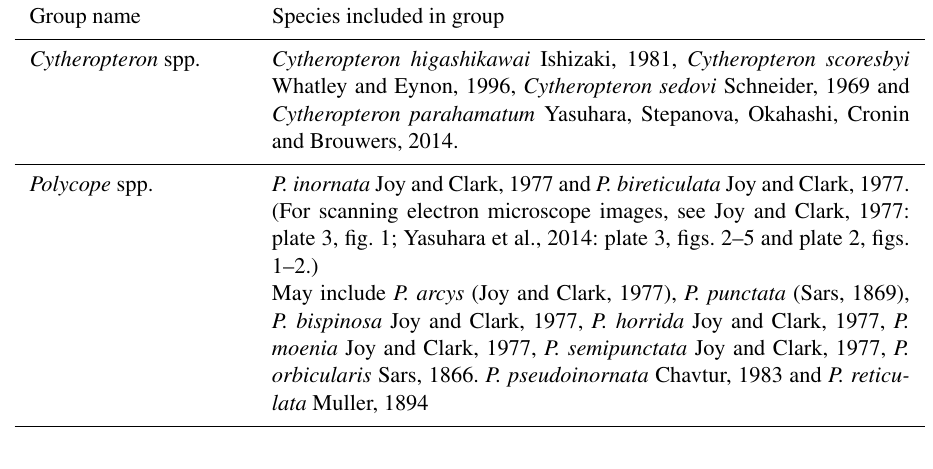
Table 3. List of species included in genus-level groups.